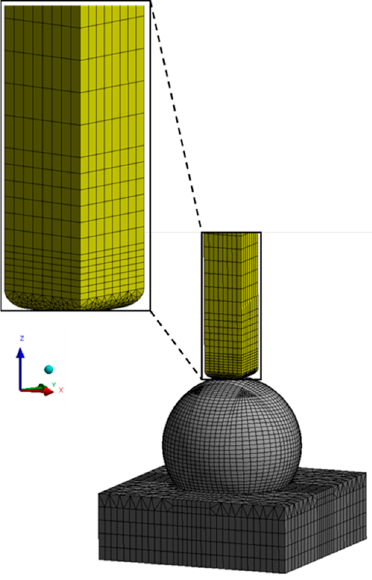
Figure 4. Numerical modeling of the probe and solder ball. Table 2. Properties of materials used in the mechanical-behavior analyses.